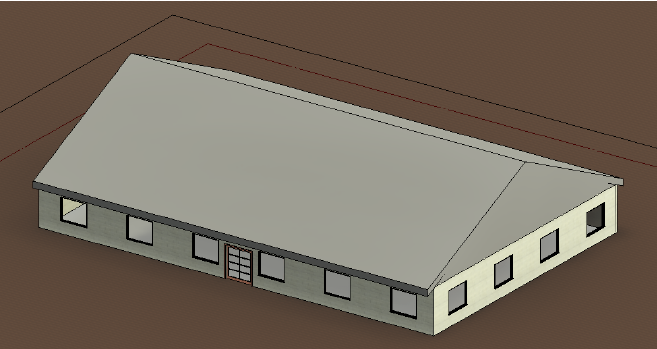
Figure 6. Overview of a small office building from DOE reference building.